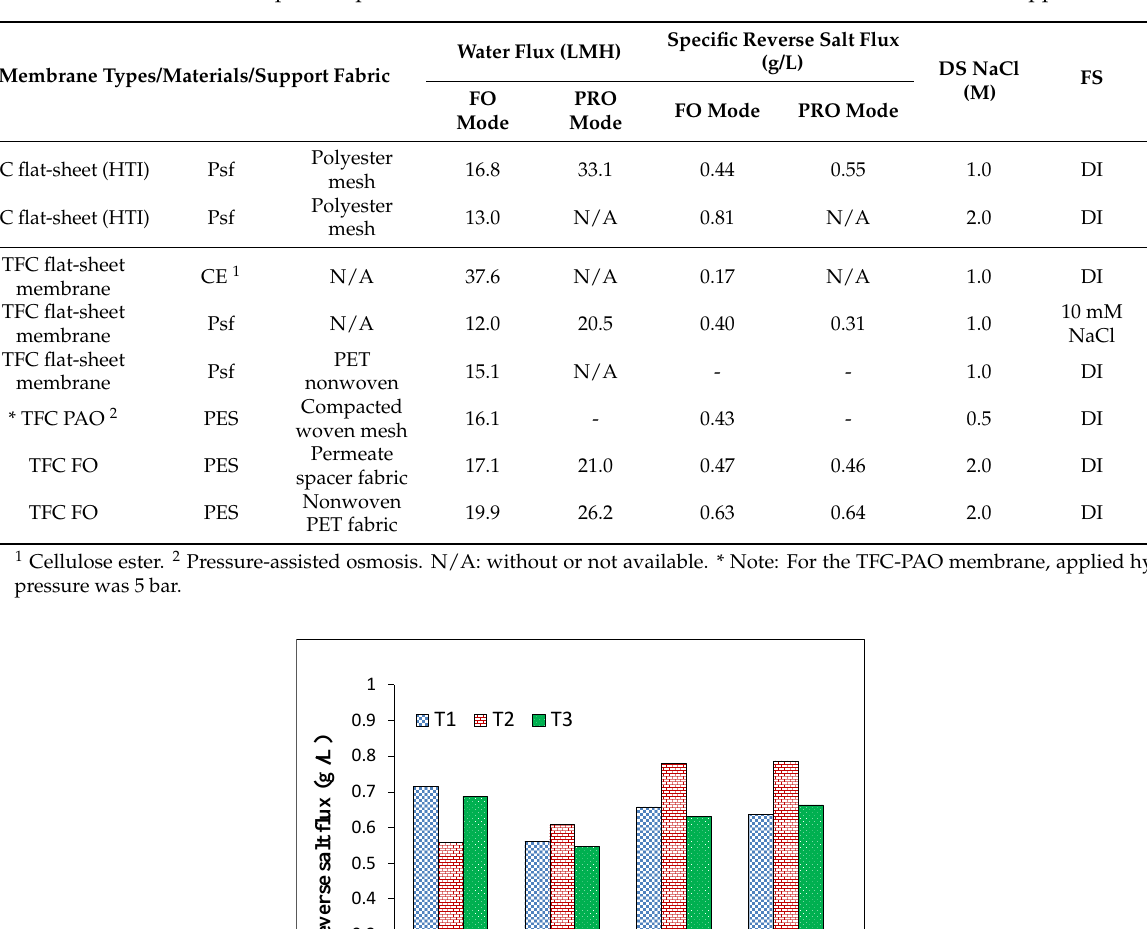
Table 6. Comparison performances of flat sheet TFC FO membranes on different fabric support.